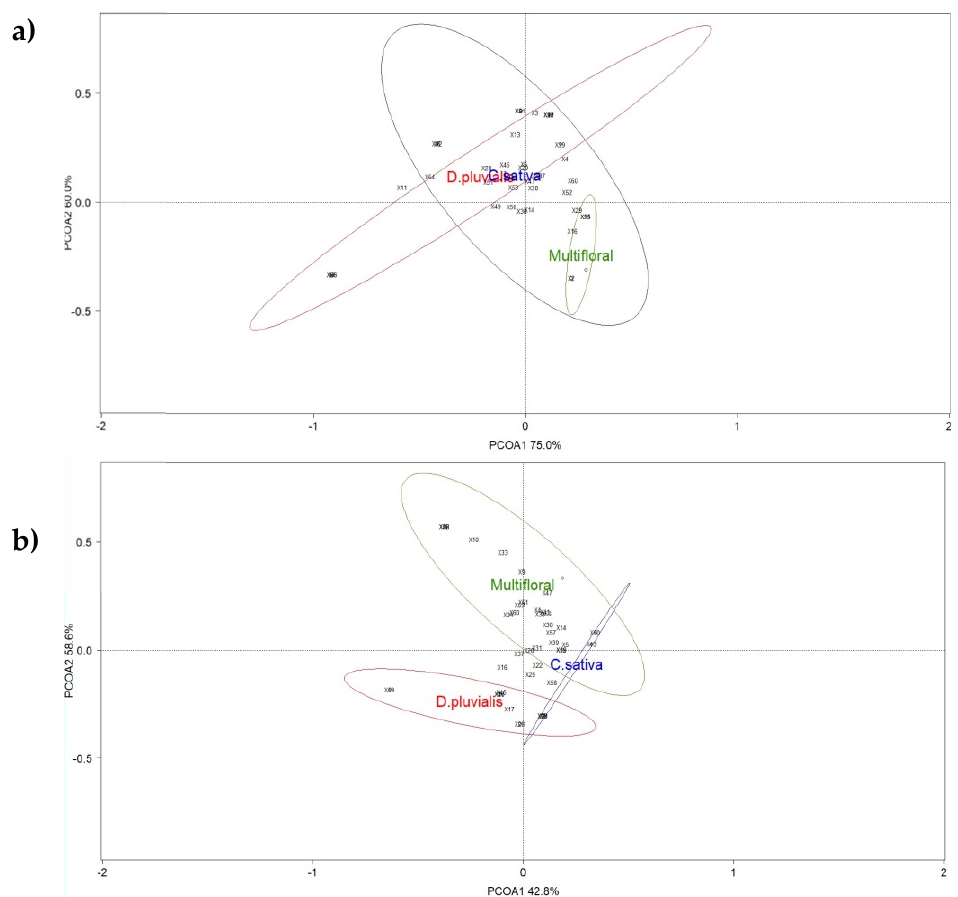
Figure 4. Principal coordinate analysis (PCoA) ordination of the three treatments (red circle: D. pluvialis ; green circle: Multifloral; blue circle: C. sativa ) based on the data collected with ( a ) pan traps and ( b ) a net through transects. Ellipses show the 80% confidence interval of the locations grouped by flower strip. Species scores are represented with numbers (Table S2). Table 3 Hill diversity indices of each treatment based on abundance data of hoverflies and bees together, bees alone and hoverflies alone where N0 = species richness; N1 = evenness; N2 = diversity weighted by relative abundance.